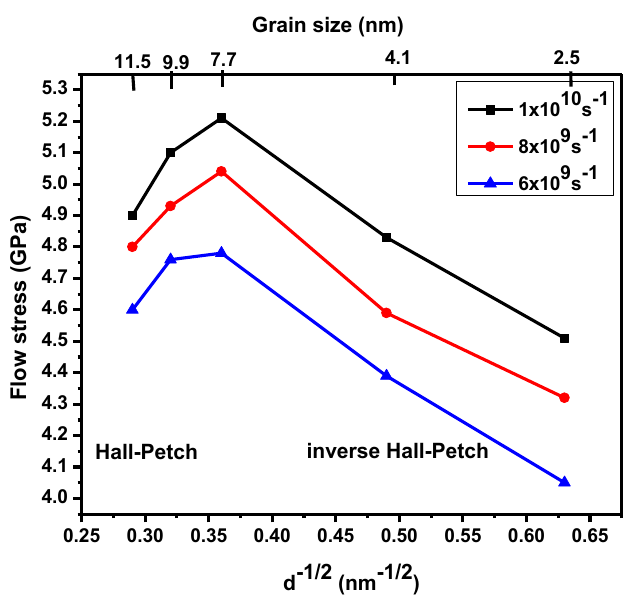
Figure 3. Relationship between flow stress and grain size under different strain rates.